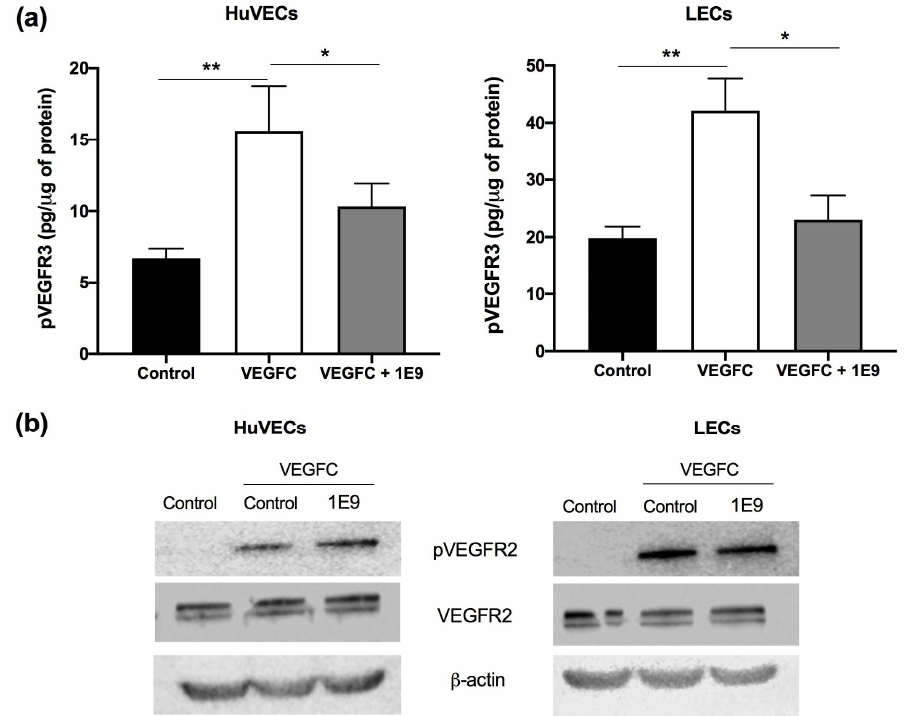
Figure 1. 1E9 antibodies inhibit the phosphorylation of VEGFR3, but not that of VEGFR2, in HuVEC and LEC cells. LECs and HuVECs were starved for 2 h and incubated with VEGFC (100 ng/mL) for 20 min in combination with 1E9 antibodies (10 µg/mL) or not. ELISA assays for VEGFR3 ( a ) or immunoblotting for VEGFR2 activation ( b ) were carried out. The control corresponds to untreated cells. * p < 0.05, ** p < 0.01 vs. control. 1E9 antibodies (10 µg/mL) significantly decreased both HuVEC and LEC cell pro- liferation after 48 and 72 h compared to the control and to the VEGFC-stimulated cells